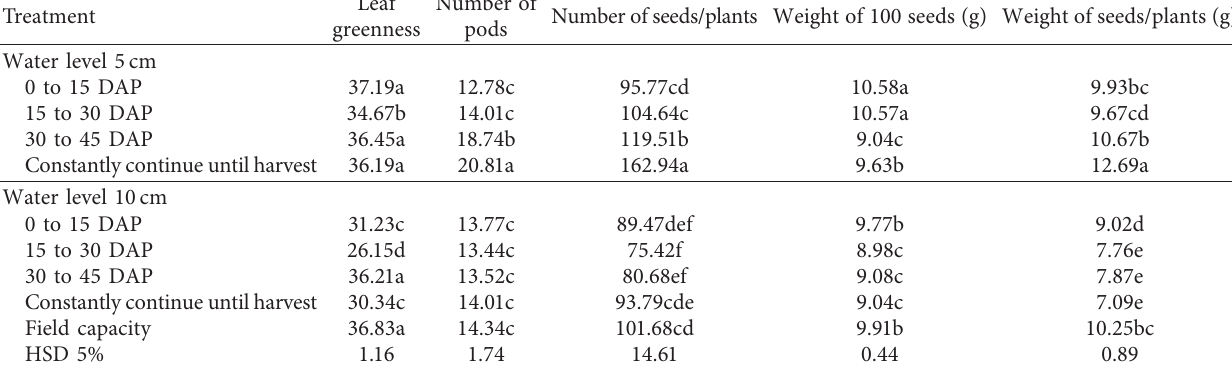
Table 3: Effect of water level and immersion time on leaf greenness, number of seeds/crops, the weight of 100 seeds, and the weight of seeds/